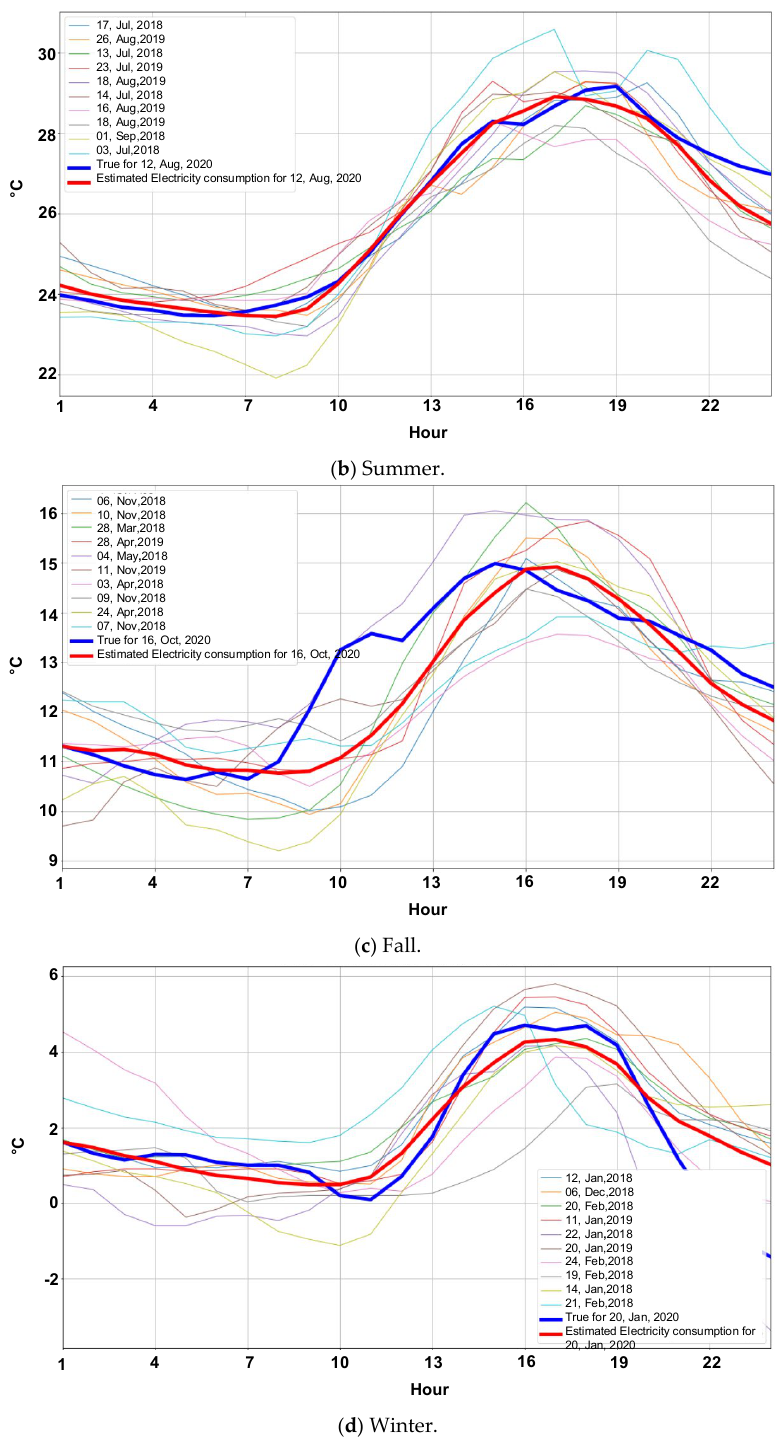
Figure 6. The outdoor temperature patterns from the KNN algorithm. As with the outdoor temperature prediction, the hourly energy consumption patterns for each season were identified (Figure 7). Based on the test data on 20 April in 2020 (Blue curve), 10 similar patterns in 2018 and 2019 were clustered for the spring season. The red curve presents the average value of the chosen 10 similar energy consumption patterns in 2018 and 2019. For the other seasons, 10 similar patterns based on the test data on specific dates were classified, and then, these were averaged. As shown in Figure 7, it can be